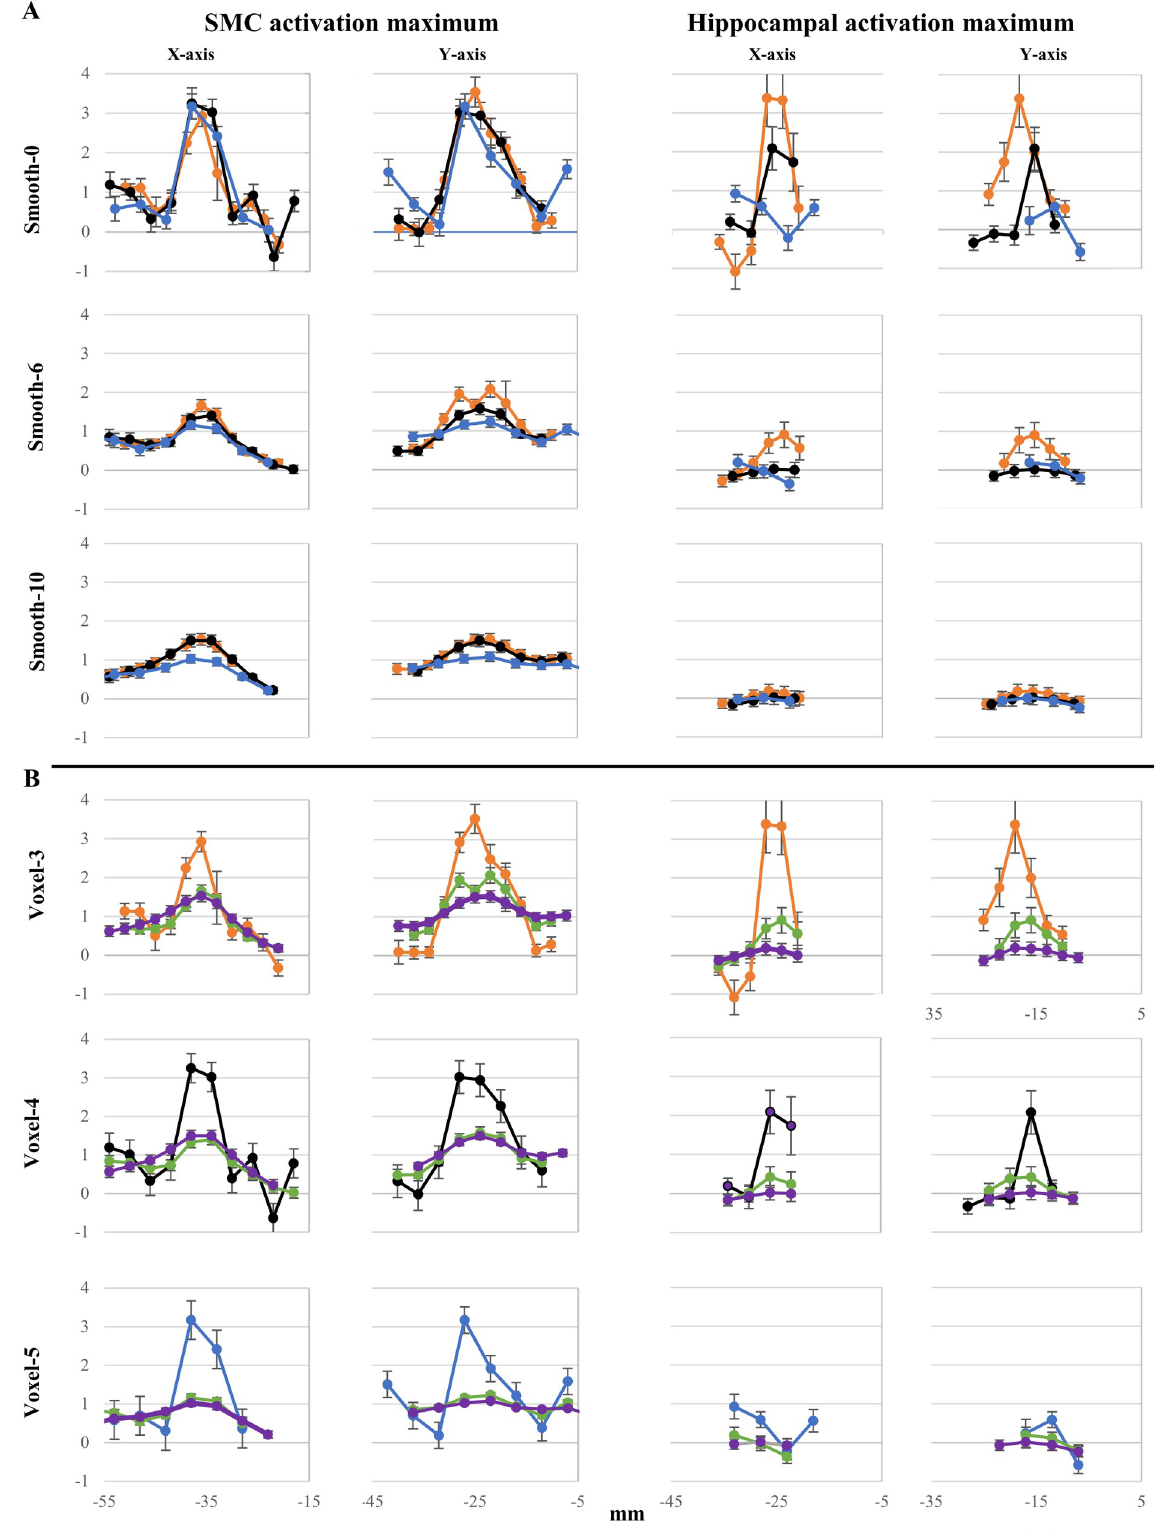
Fig 2. Effects of smoothing and voxel size on measures of activation in SMC and the hippocampus from a single subject. The beta parameter estimate from the sequence learning contrast was plotted for each voxel along the x- and y-axis of the activation maximum.